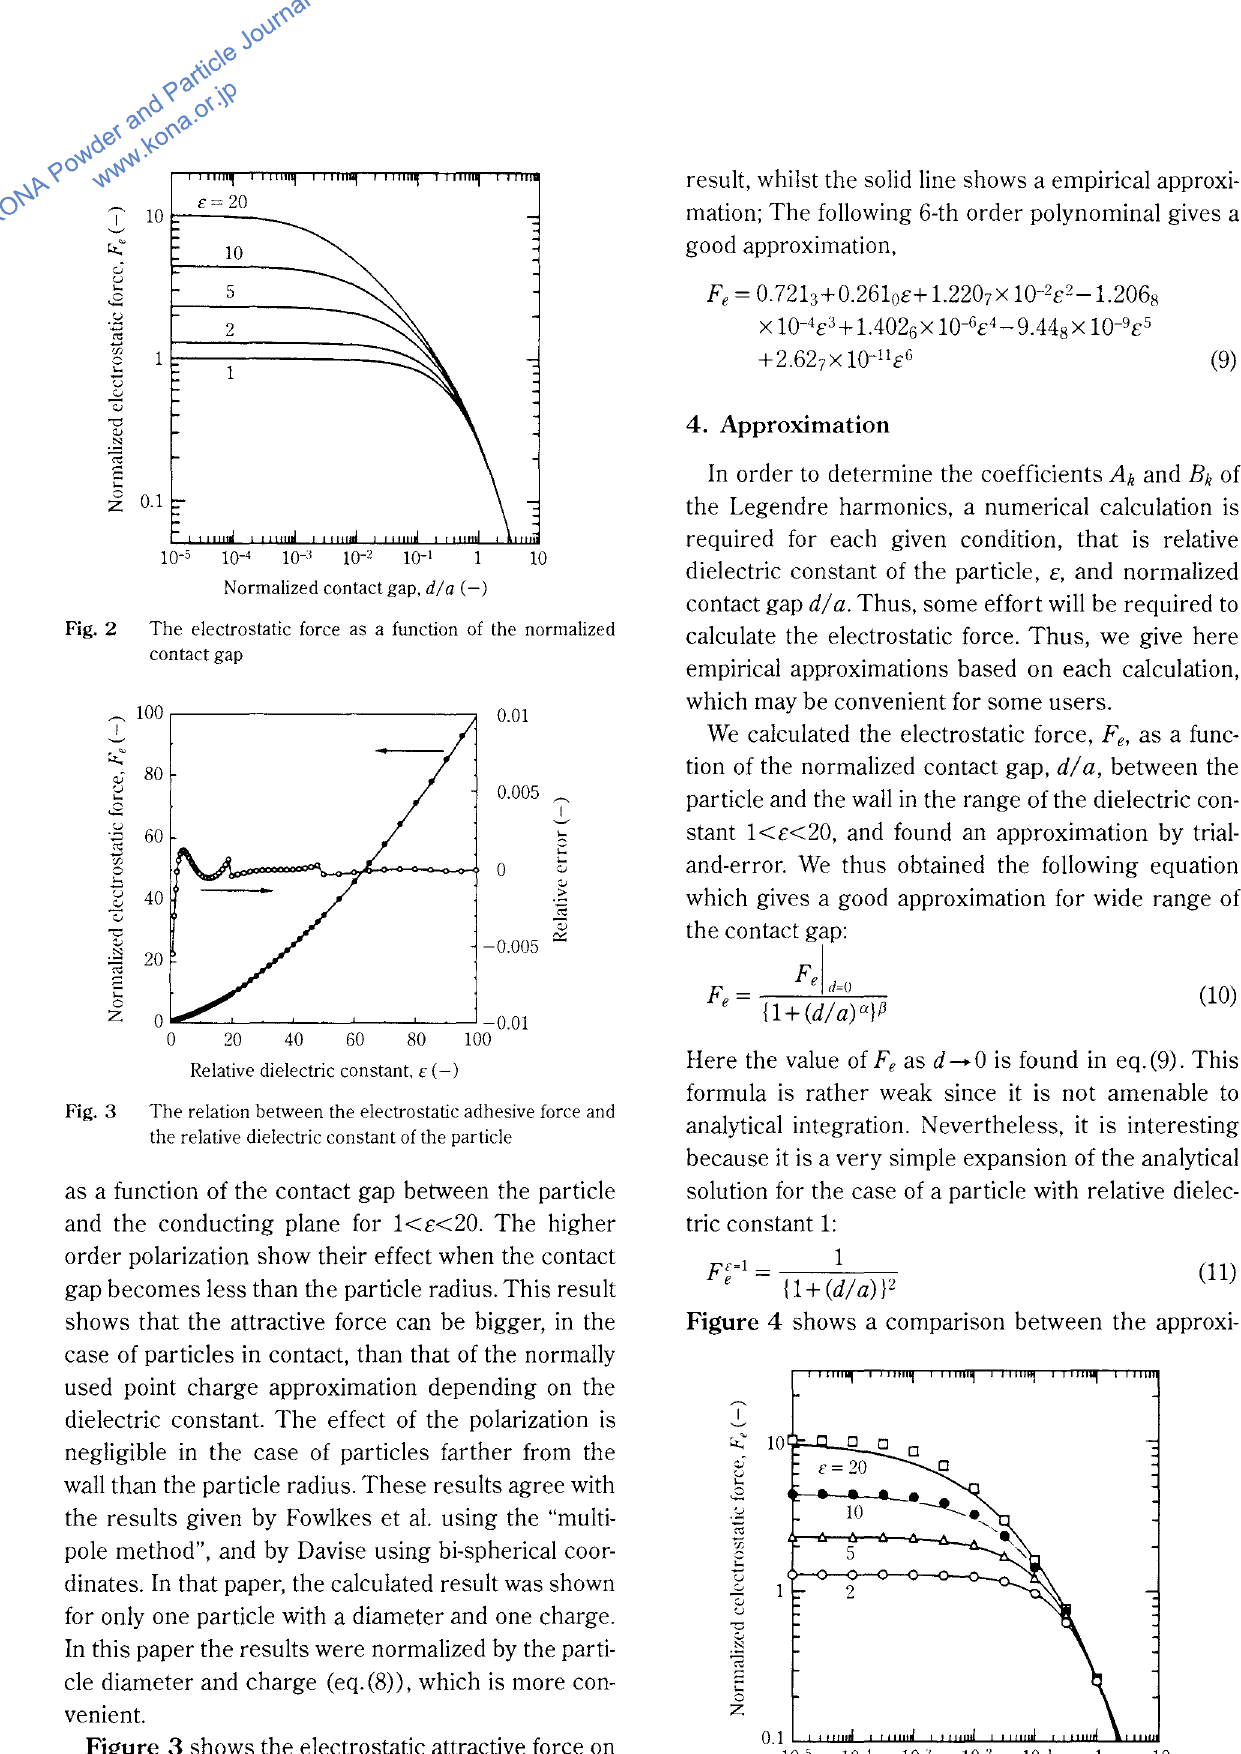
Normalized codntact gap, d/ a (-) The comparison between the strictly calculated values and the